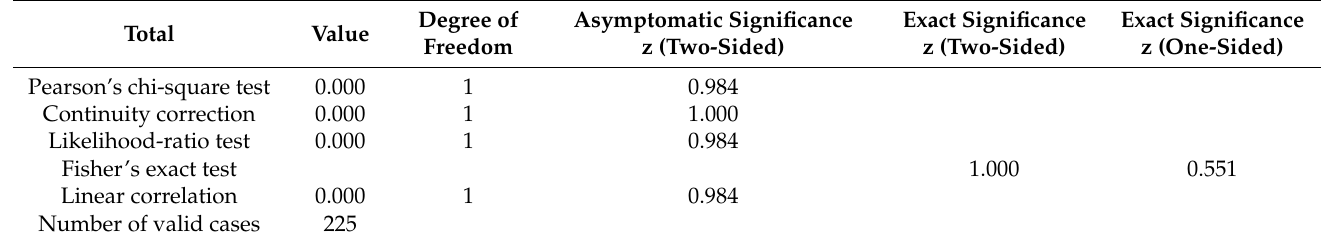
Table 1. Chi-square test (FT-IR dendrograms). Influence of husbandry type on the cluster formation of E. coli isolated from pigs from pasture 1 ( n = 120) and pasture 2 ( n = 120).